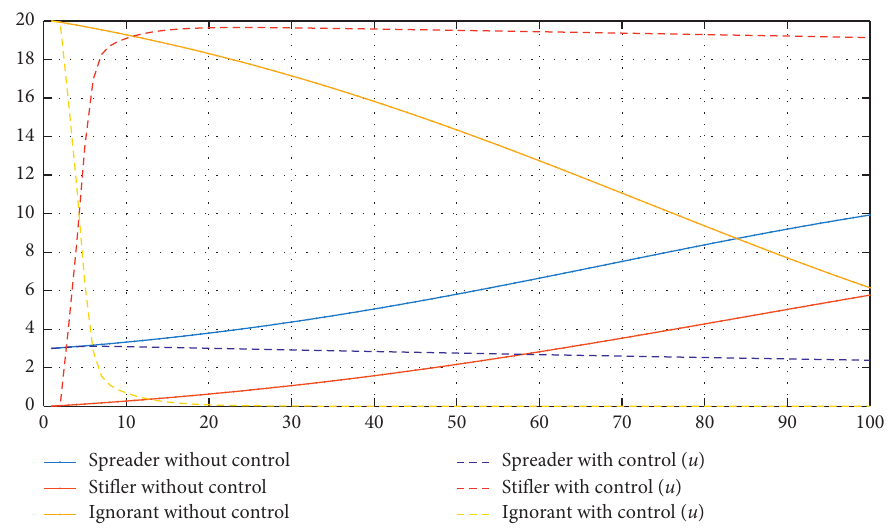
Figure 4: Dynamics with control u